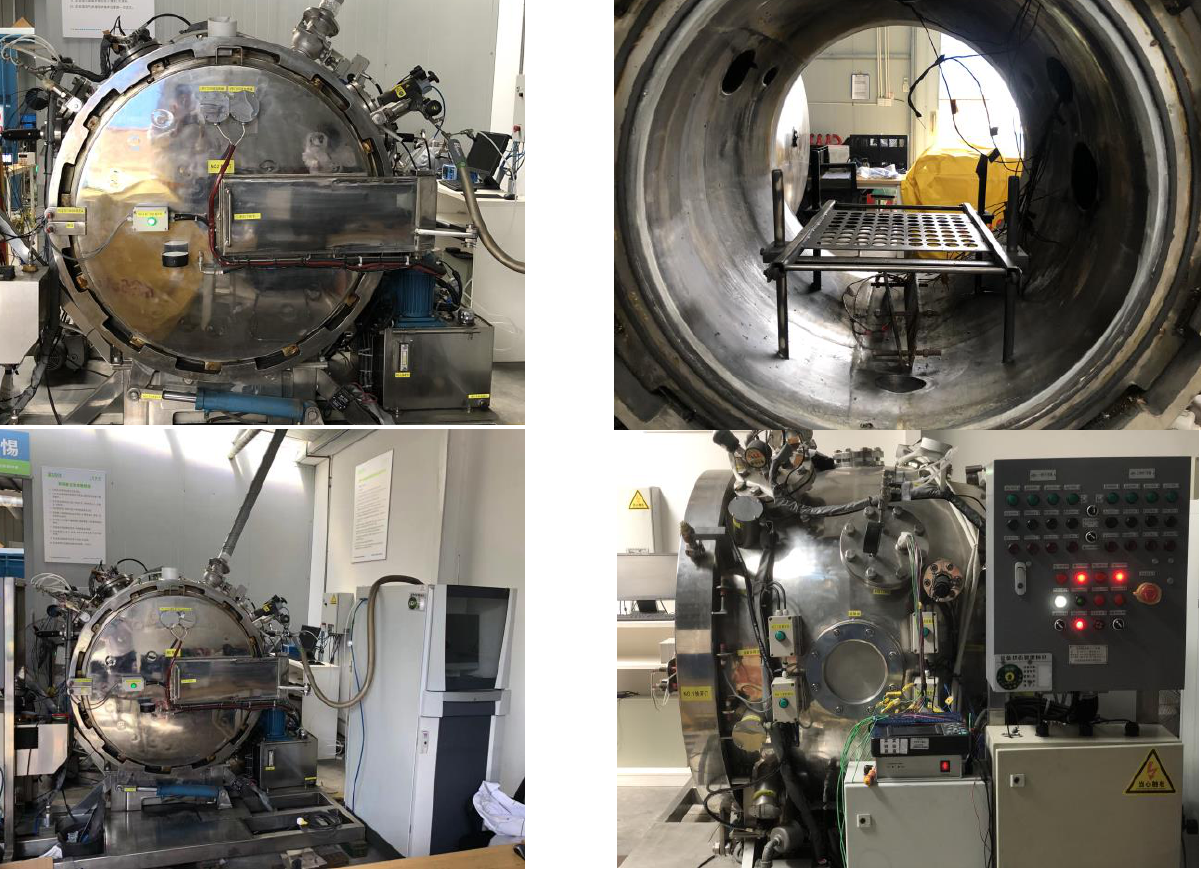
Figure 1. Physical picture of AEC constant volume adiabatic explosion chamber.